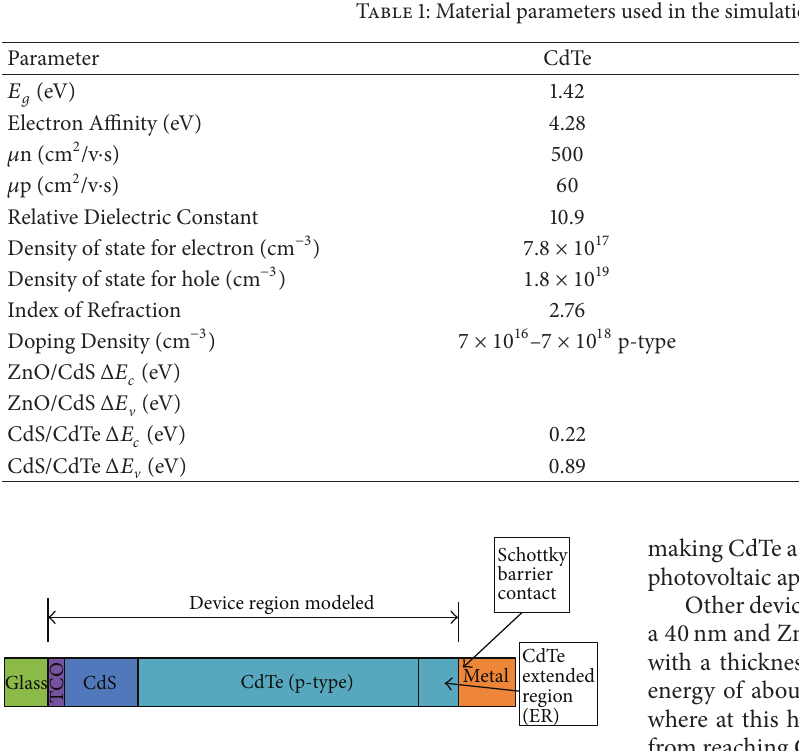
Figure 1: The configuration of a CdTe thin-film solar cell. A 2 𝜇 m CdTe layer, a 40nm CdS layer, and 0.5 𝜇 m TCO(ZnO) are assumed for the simulation; layers are not scaled. Light is illuminated from